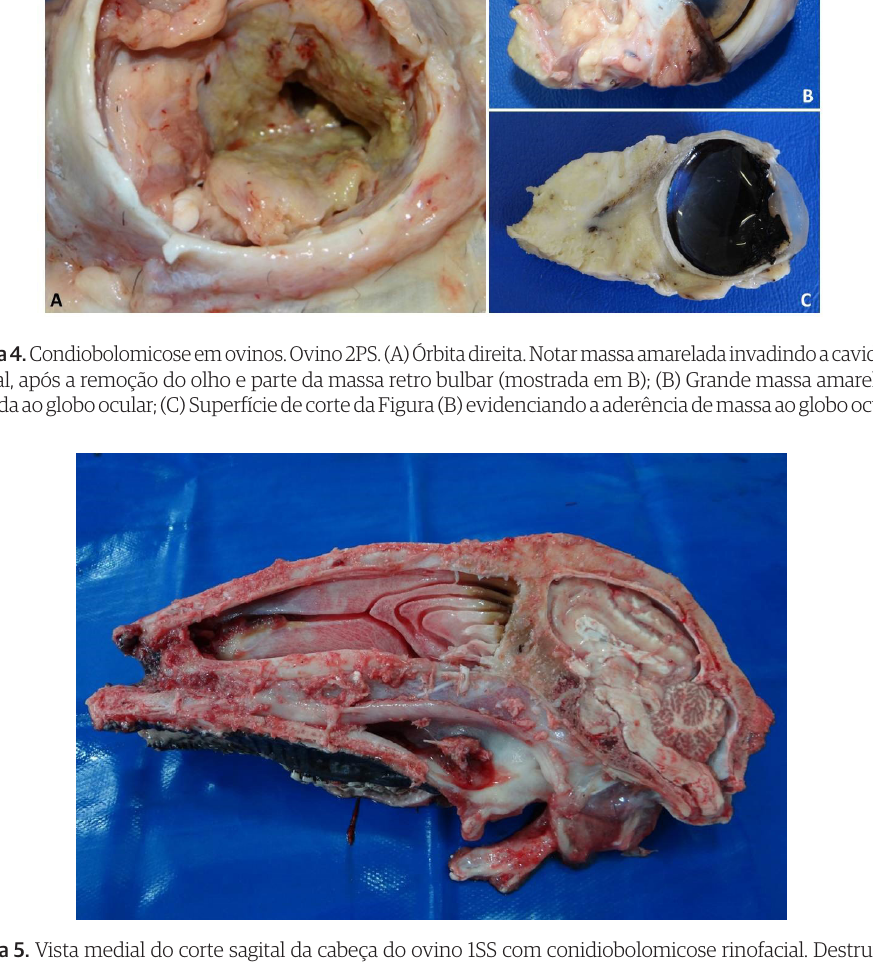
figura 5. Vista medial do corte sagital da cabeça do ovino 1SS com conidiobolomicose rinofacial. Destruição parcial focal leve da porção rostral da cavidade